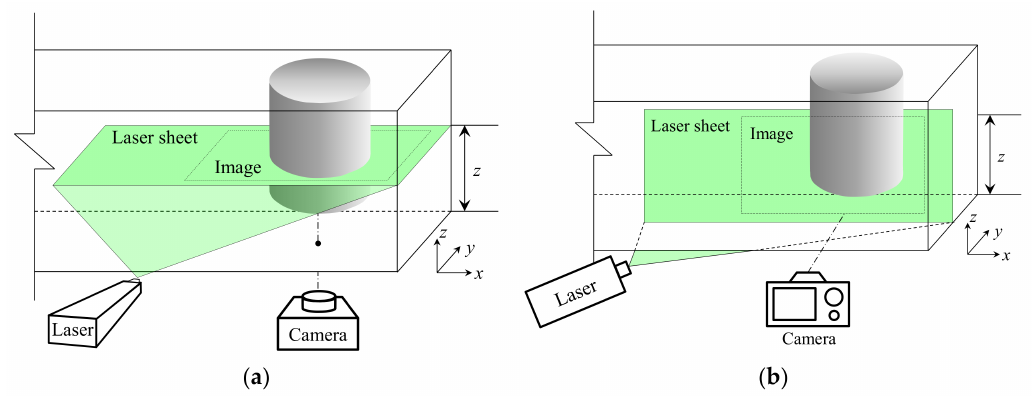
Figure 6. Descriptions of PIV measurements: ( a ) x – y plane measurements and ( b ) x – z plane